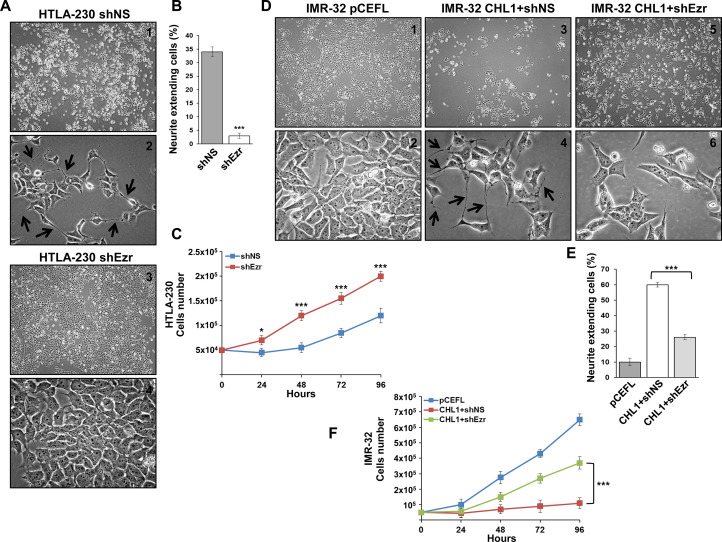
Ezrin knockdown interferes with neuronal differentiation and enhances proliferation in NB cells.Morphological characteristics of cells plated 48 hours after transfection and photographed three days later. (A) HTLA-230 cells transfected with shNS (1–2) or shEzr (3–4): shEzr-HTLA-230 grew faster and lost the neurite-like extensions detectable in control cells (see arrows in photo 2). (D) IMR-32 cells transfected with the negative control pCEFL (1–2) or cotransfected with pCEFL-CHL1 and shNS (3–4) or shEzr (5–6): over-expression of CHL1 in IMR-32 cells strongly reduced growth rate and induced neural differentiation with protrusion of neurite-like extensions (see arrows in photo 4), whereas the co-silencing of ezrin clearly reduced CHL1 effects. (Magnification 4x and 40x). (B-E) Histograms report the percentages of cells extending neurite-like protrusions. Data are representative of three independent experiments ± SD (*** p <0.001). (C-F) HTLA-230 or IMR-32 cells were plated 48 hours after transfection or cotransfection and cultured for 4 days. Every day, cells were trypsinized and counted. Data are representative of three independent experiments ± S.D. (* p < 0.05; *** p < 0.001).